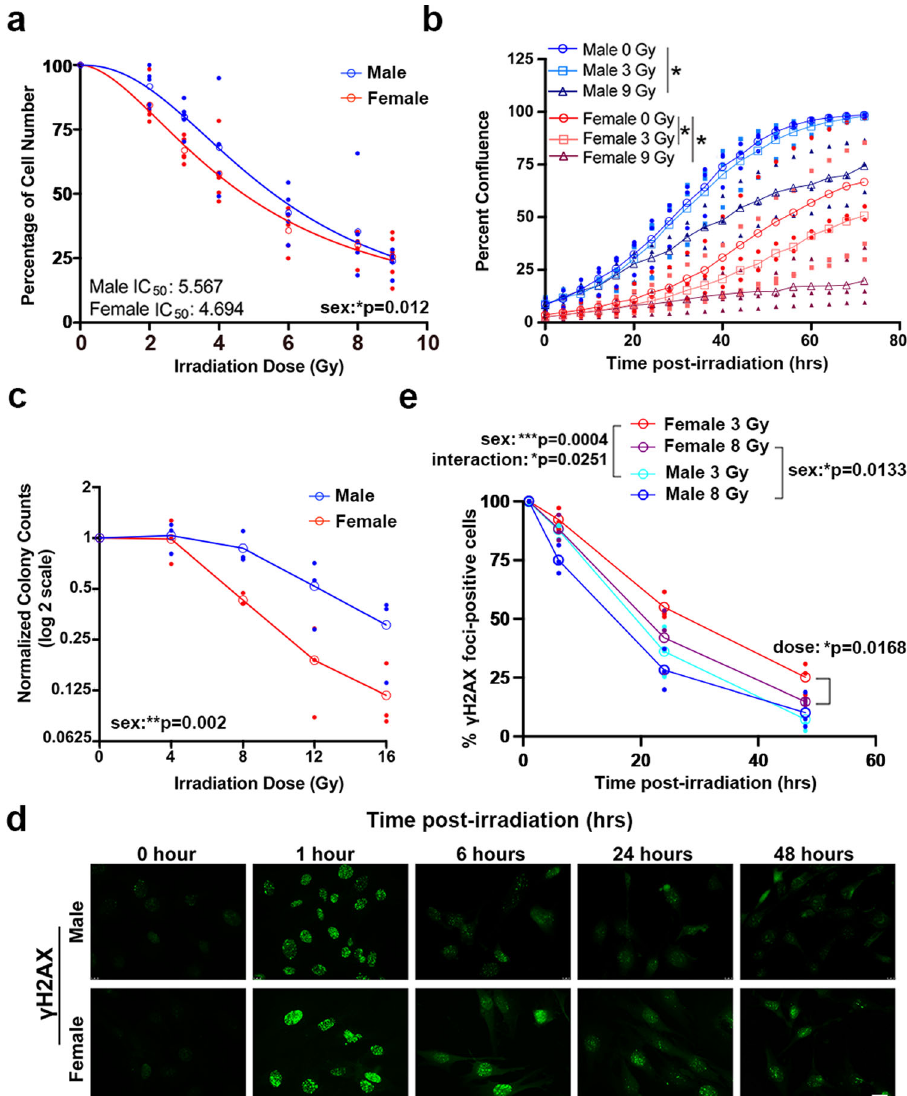
Fig. 2 Female mouse GBM model astrocytes are more sensitive to radiation treatment. a Irradiation dose response curves in male and female Nf1 − / − DNp53 astrocytes. Curves represent combined values from fi ve separate established cell lines — each consisting of a corresponding male and female line generated at the same time. Male IC 50 = 5.567 (95% CI 5.094 – 6.088), female IC 50 = 4.694 (95% CI 4.349 – 5.061). Two-way ANOVA: dose p < 0.0001, sex p = 0.0123, interaction p = 0.6034. Open symbols are the means of the individual data points, which are presented as closed symbols. Lines are non- linear fi ts to the individual data points ( n = 5/sex). b Male and female Nf1 − / − DNp53 cell growth curves after irradiation with 0, 3, or 9 Gy. Cell growth was tracked using live cell imaging; images were taken every 4 h for 3 days and used to calculate percent con fl uence over time. Two-way repeated measures ANOVA — male 0 Gy vs male 3 Gy: time p < 0.0001, dose p = 0.3394, interaction p = 0.9087; male 0 Gy vs male 9 Gy: time p < 0.0001, dose p = 0.0325, interaction p < 0.0001; female 0 Gy vs female 3 Gy: time p < 0.0001, dose p = 0.0183, interaction p < 0.0001; female 0 Gy vs female 9 Gy: time p < 0.0001, dose p = 0.05, interaction p < 0.0001. Open symbols are the means of the individual data points, which are presented as closed symbols. Lines are non-linear fi ts to the individual data points ( n = 3/sex). c Normalized colony counts from the clonogenic assay in male and female Nf1 − / − DNp53 cells 5 days after irradiation with 0, 4, 8, 12, or 16 Gy. Two-way ANOVA: dose p < 0.0001, sex p = 0.002, interaction p = 0.111. Open symbols are the means of the individual data points, which are presented as closed symbols. ( n = 3/sex). d Representative immuno fl uorescence images of male and female Nf1 − / − DNp53 astrocytes stained for γ H2AX 0, 1, 6, 24, and 48 h after irradiation with 3 Gy. Scale bar, 20 μ m. e Quanti fi cation of the percent of cells with >10 γ H2AX foci at each timepoint in male and female Nf1 − / − DNp53 astrocytes following irradiation with 3 or 8 Gy. Two-way ANOVA — male 3 Gy vs